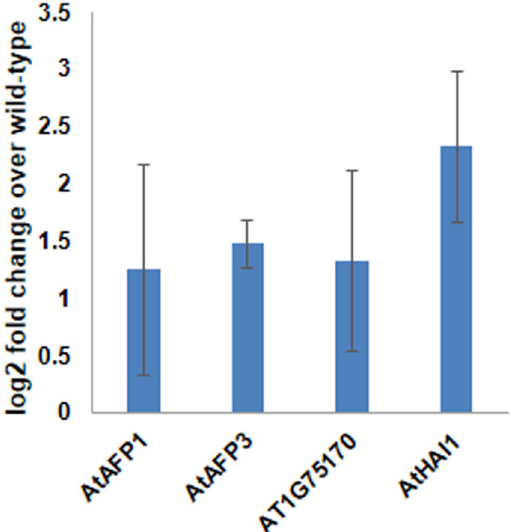
Figure 7. AtGBF3 overexpression increased the expression of ABA signaling genes. Expression of four potential targets of AtGBF3 was studied by RT-qPCR analysis in AtGBF3 overexpression plants. The data was normalized to AtACTIN2 expression levels and the relative change over wild type plants was calculated using 2 −ΔΔ Ct method. The values are mean ± SE of three biological